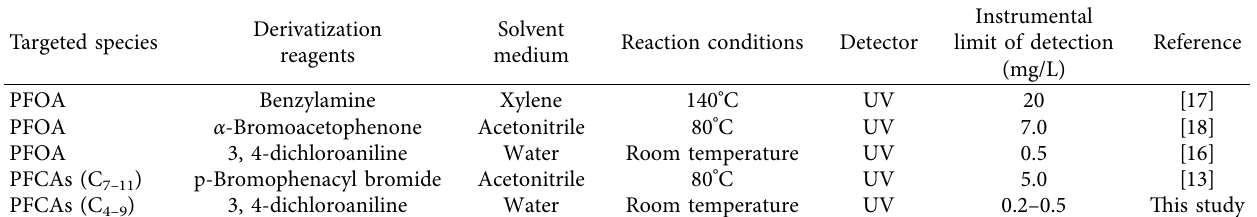
Table 1: Comparison of HPLC determination of PFCAs coupled with the derivatization